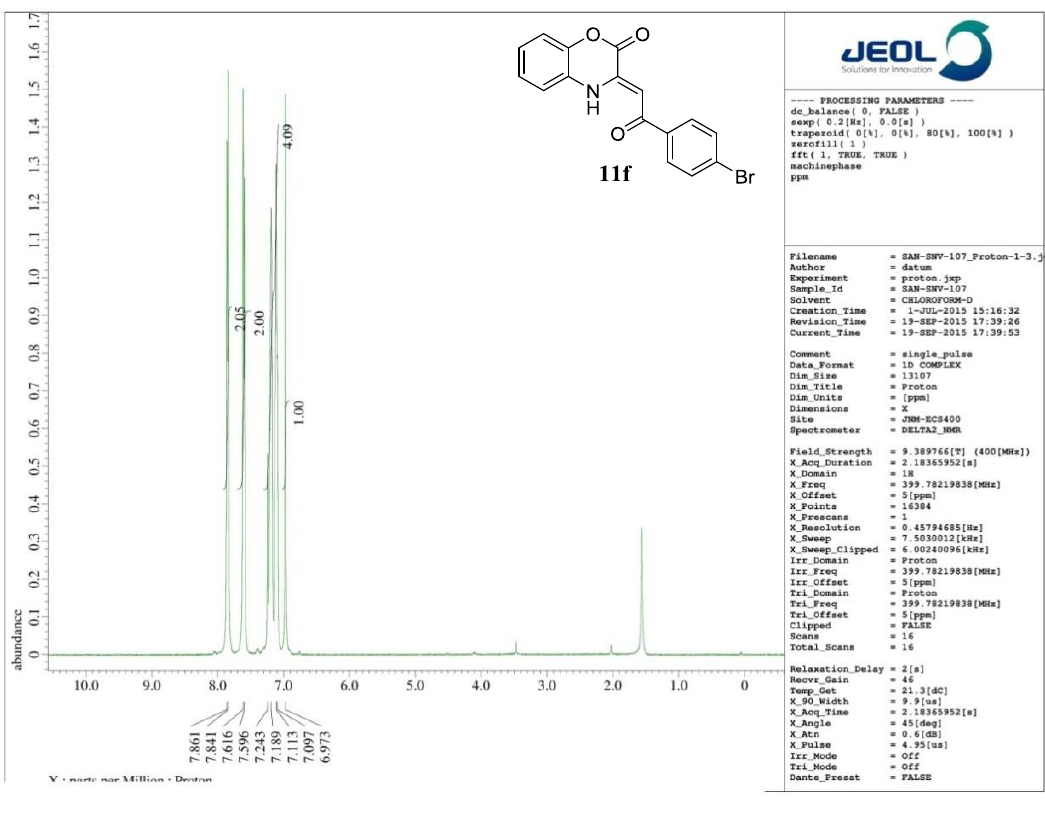
Figure 11. 1 H NMR Spectra of Compound 11f.